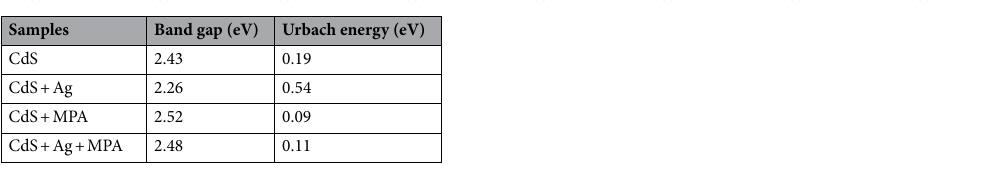
Table 1. Bandgap versus Urbach